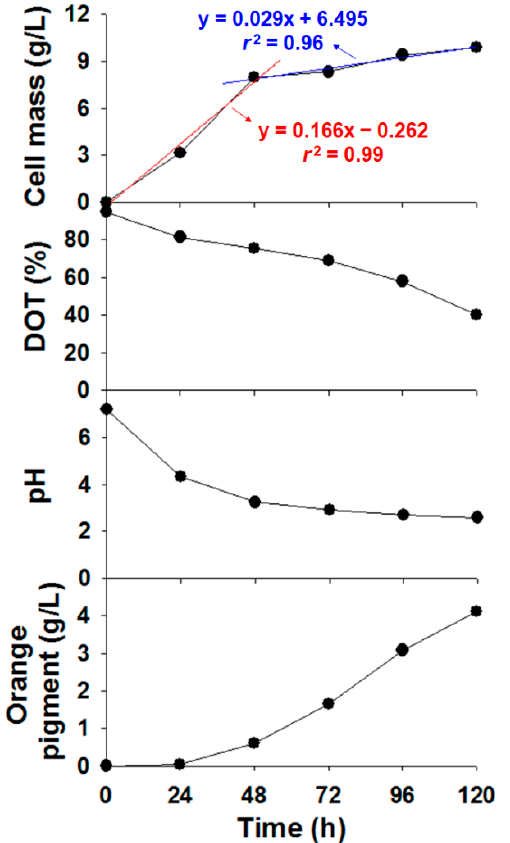
Figure 2. Production profiles of orange Monascus pigments in a 5 L bioreactor. DOT = dissolved Figure2. Productionprofilesoforange Monascus pigmentsina5Lbioreactor. DOT = oxygen tension.